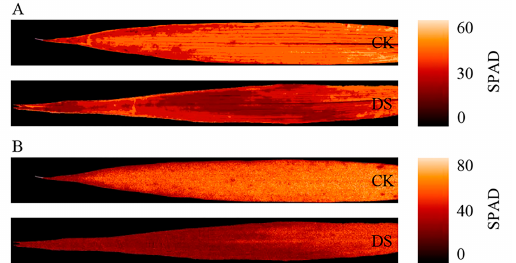
Figure 8. SPAD values map at the leaf level estimated by the characteristic reflectance and first derivative. ( A , B ) SPAD values map at the leaf level estimated by the 549 nm reflectance and 735 nm first derivative. CK, control; DS, drought stress. ENVI 5.3 (ITT, Visual Information Solutions, Boulder, CO, USA) was used to obtain the SPAD values map.